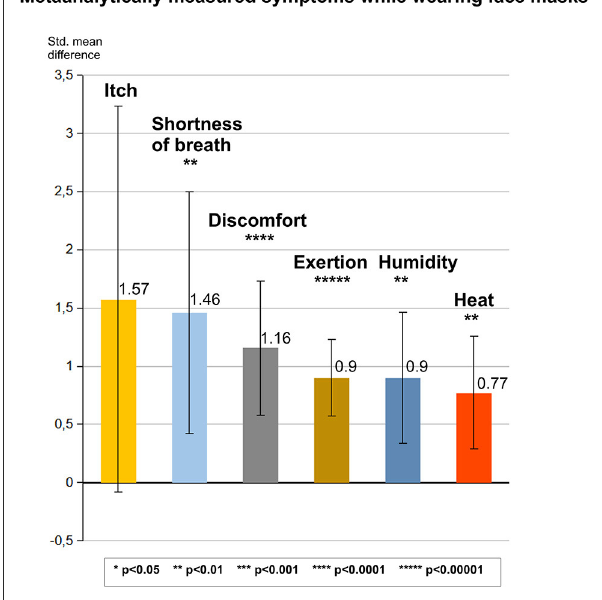
FIGURE12 Summary of pooled meta-analytic evaluation of face mask-wearing sensations measured with standardized Borg-. Likert-, VAS-scales, or similar. The height of the bars reflects the SMD (standard mean difference), their error bars correspond to the confidence intervals. Five out of 6 complaint categories (83%) are above the strong effect size threshold of > 0.8 of the standard mean difference values according to Cohen (102). The meta-analytical statistical data were as follows (SMD standard mean difference): Itch: SMD =